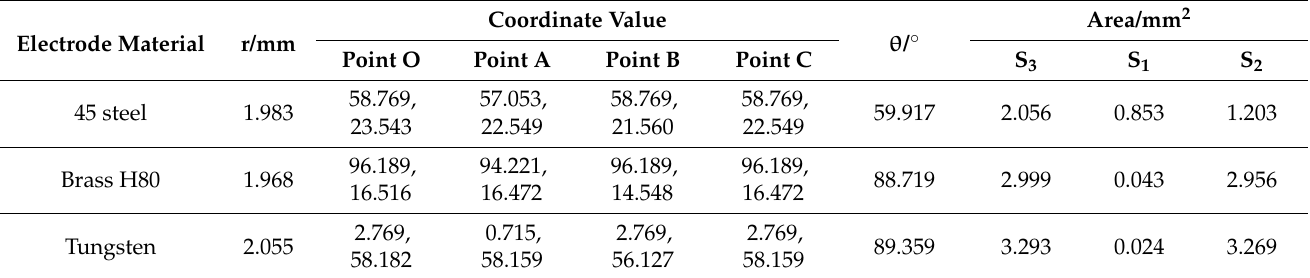
Table 3. Calculation of the data required for the determination and calculation of the erosion vol- ume.